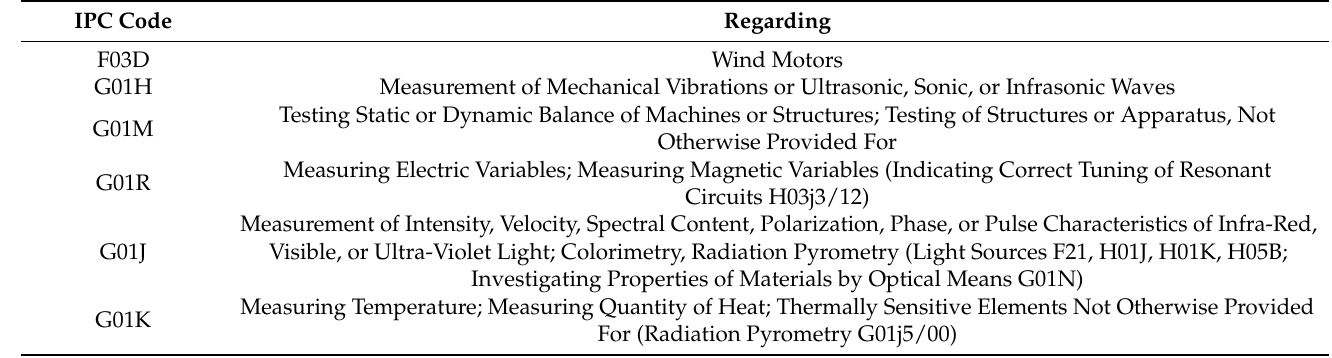
Table 1. IPC codes used in the prospecting of current patent